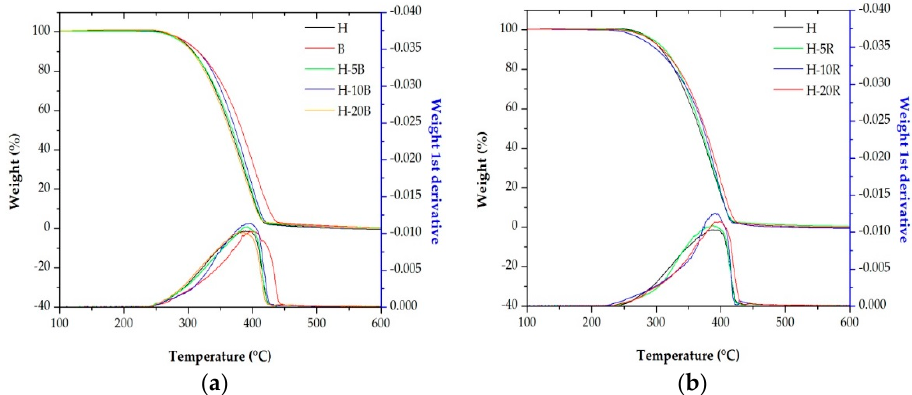
Figure 9. TGA and DTG curves of membranes annealed and stretched at the same temperature for the PP homopolymer and its blends with the ( a ) block and ( b ) random copolymers.